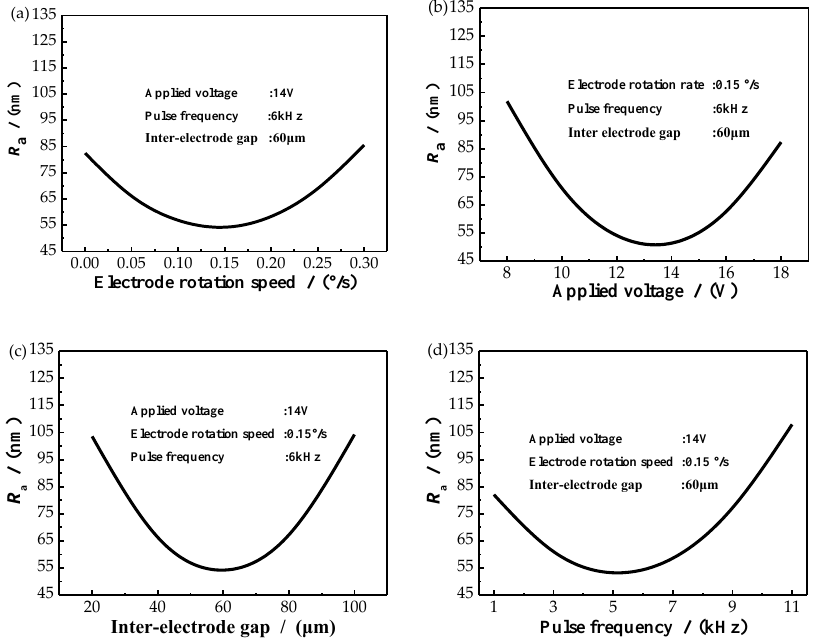
Figure 4. Main effects of process parameters on R a. ( a )Electrode rotation speed; ( b ) Applied voltage; ( c ) Interelectrode gap; ( d ) Pulse frequency.